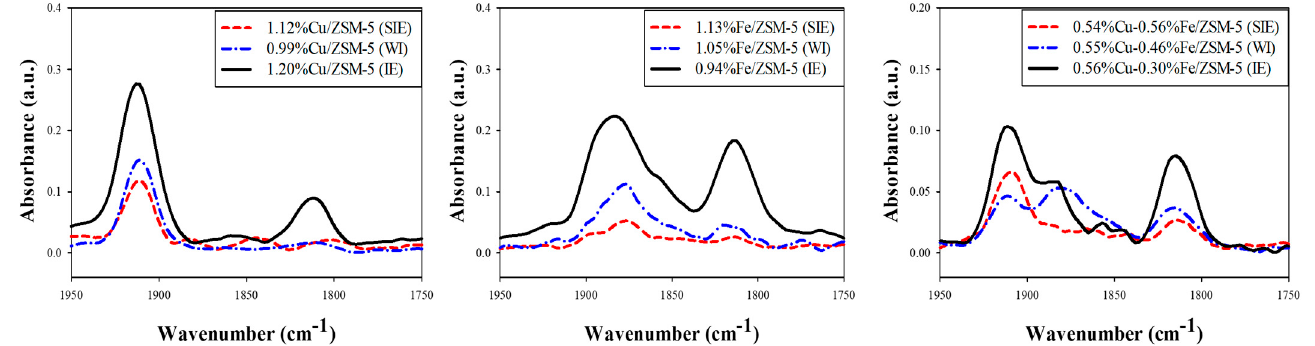
Figure 3. NO-FTIR of the catalysts prepared with different methods.